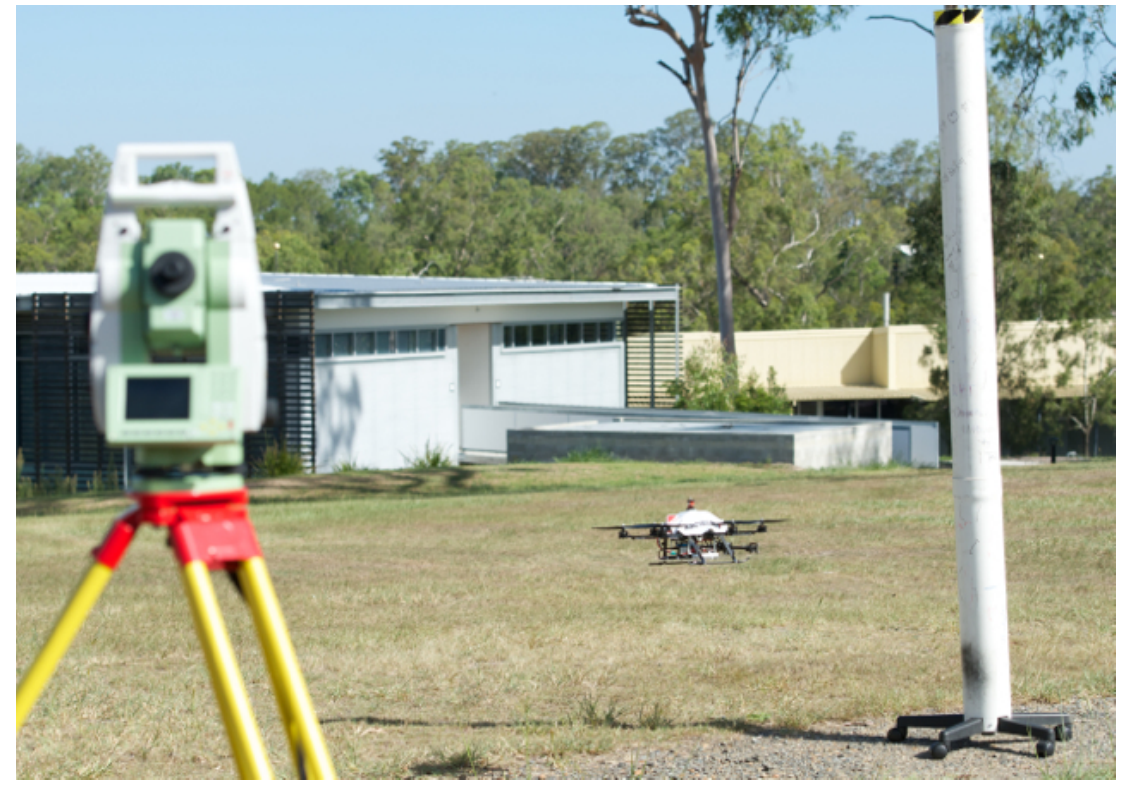
Figure 19. Experimental setup for outdoor flights. The VTOL platform is shown pointing towards the pole. An actuated surveying laser tracks a reflective beacon on the aircraft for position ground